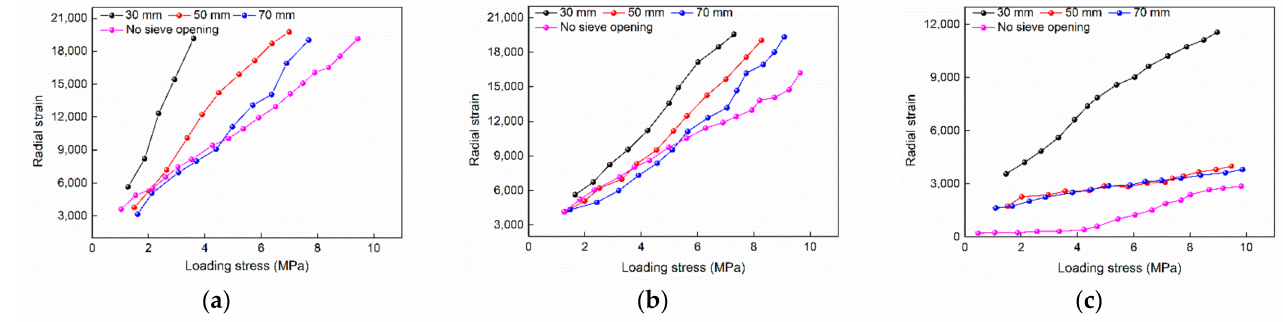
Figure 8. Loading stress–strain curve of three kinds of pipes with different sieve opening spacings: ( a ) PVC; ( b ) PP; ( c )